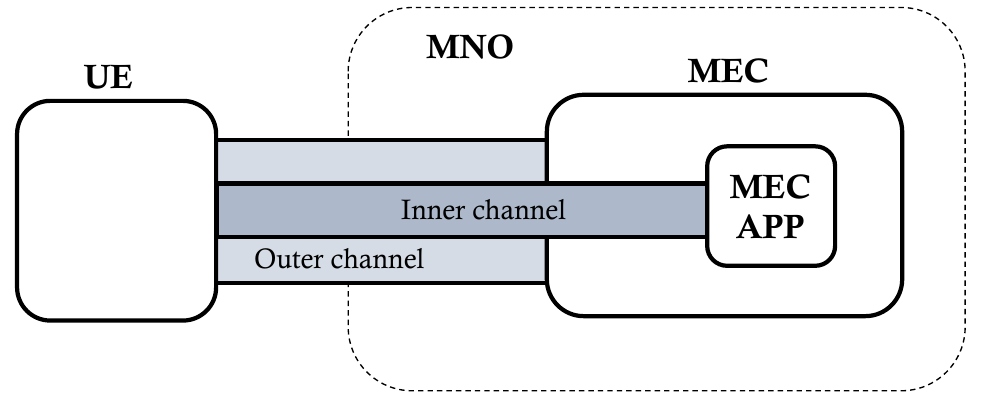
Figure 3. Solution idea for accessing APPIFY in